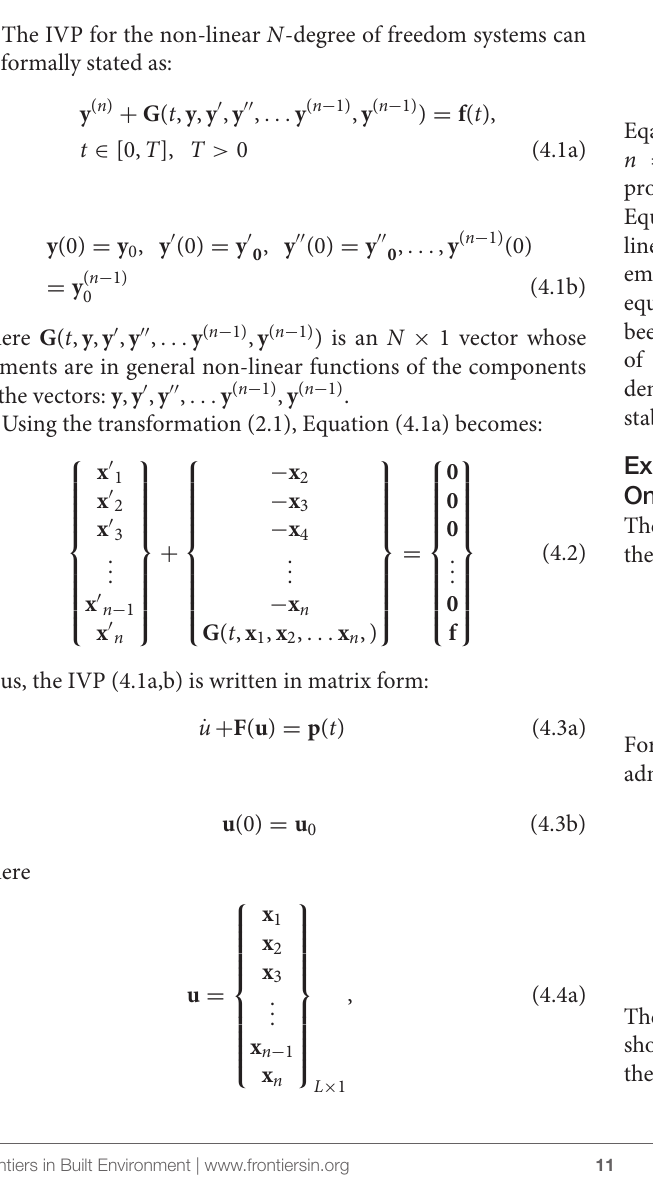
y ex in Example −